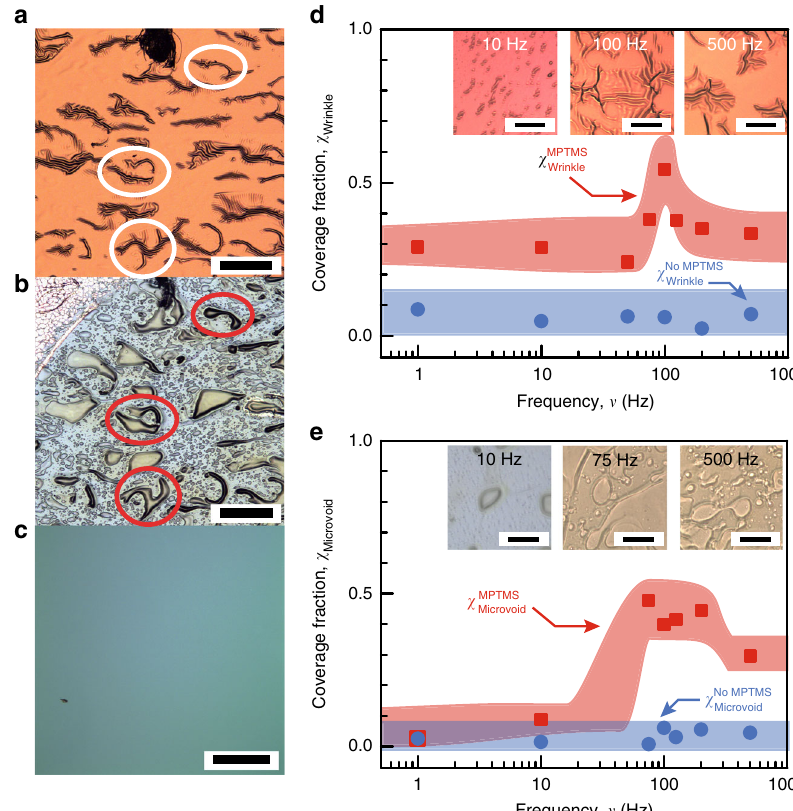
Fig. 3 Fracture surface analyses of epoxy-Cu-MPTMS-SiO 2 structures under fatigue loading. a Representative optical micrographs from an as-obtained Cu fracture surface (scale bar = 300 μ m), b the same with the metal fi lm etched off to expose the polymer (scale bar = 300 μ m), and c the SiO 2 fracture surface (scale bar = 100 μ m). The sizes and shapes of the metal wrinkles and the polymer microvoids are correlated (circles regions). Average d metal wrinkle coverage χ Wrinkle (scale bar = 100 μ m) and e microvoid coverage χ Microvoid (scale bar = 200 μ m) from fracture surfaces of structures with (red squares), and without (blue circles) MPTMS. Representative optical micrographs inset in d and e capture metal wrinkling and polymer microvoiding at = 1.3 kPa. The width of the bands drawn through the data points connote the select frequencies. The data in this fi gure were from experiments at p H 2 O experimental uncertainties measured as standard